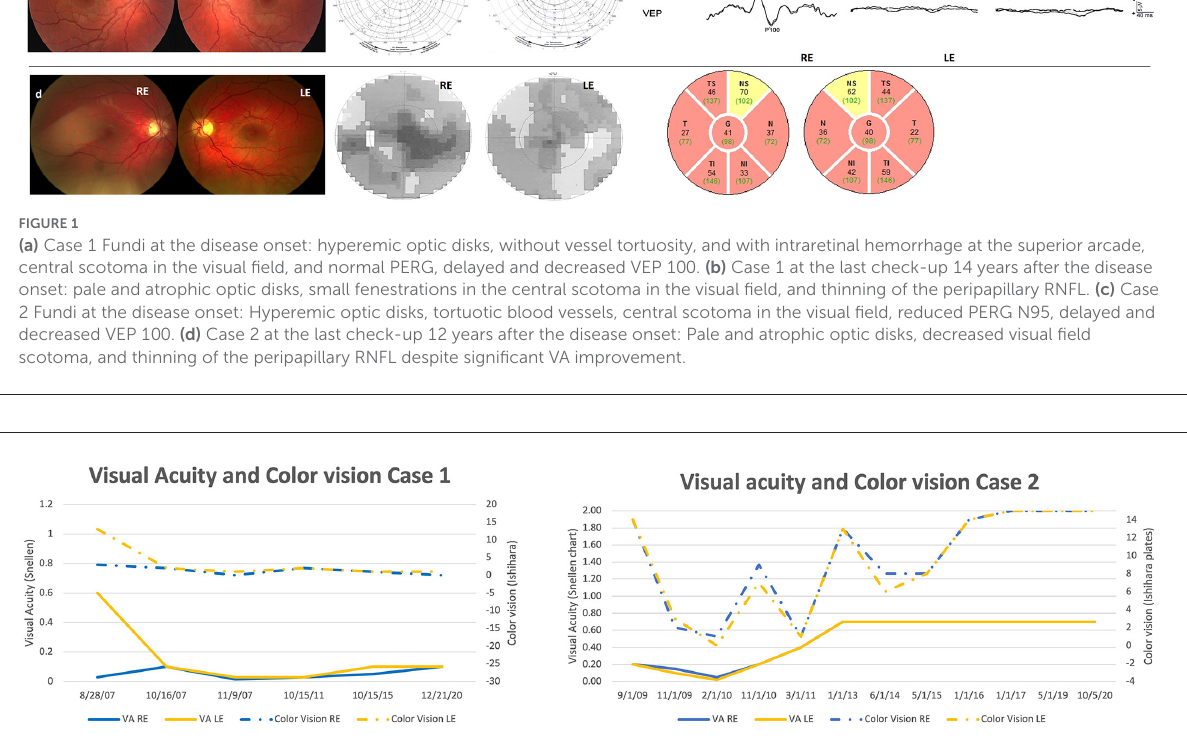
FIGURE2 Improvement in VA and color vision, modest in Case 1 and significant in Case 2 with complete recovery of color vision.